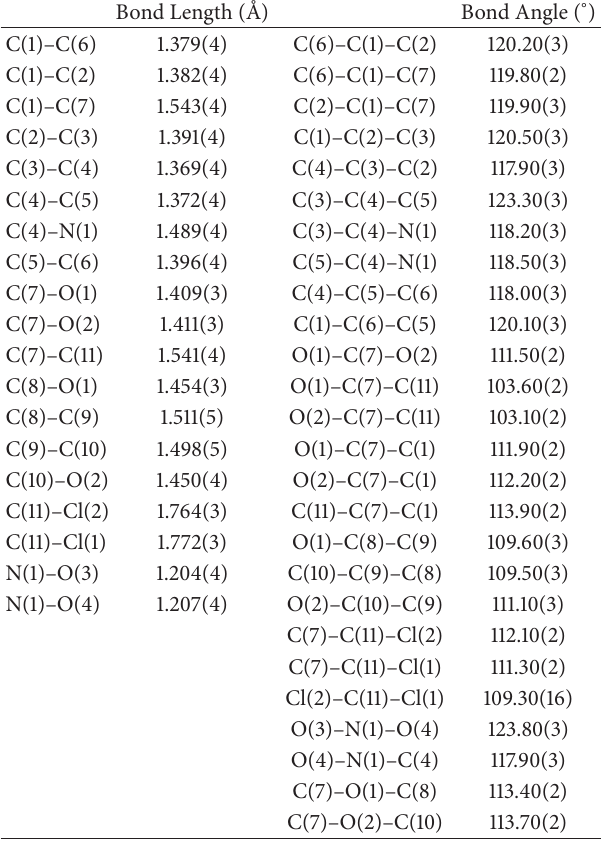
Table 2: Selected bond lengths (˚A) and angles ( ∘ ) for the title